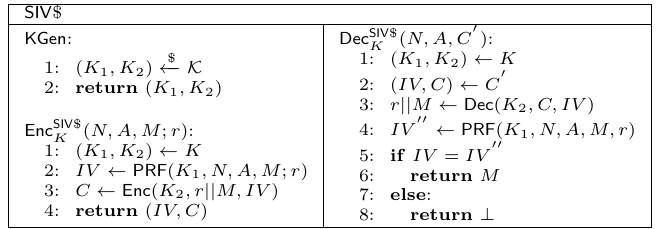
Table 3: The SIV $